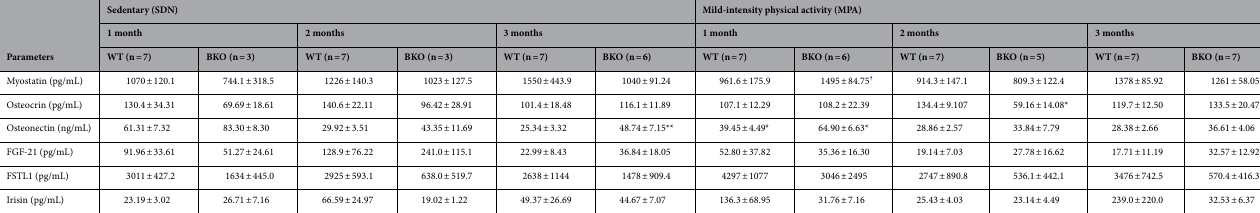
Table 3. Serum myokine and osteokine levels of WT and BKO mice after SDN and MPA. Data are mean ± SE. WT wild-type, BKO hemizygous β-globin knockout thalassemia, FGF-21 fibroblast growth factor-21, FSTL1